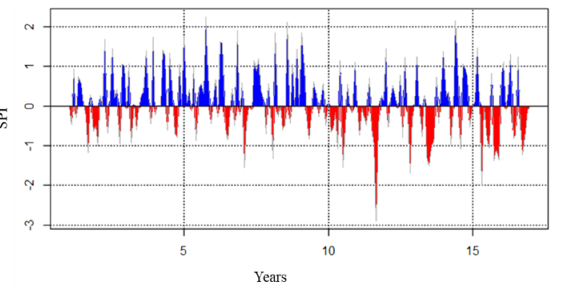
Figure 9. Three-month SPI (years: 2000–2015). Figure 10. Four-month SPI (years: 2000–2015).